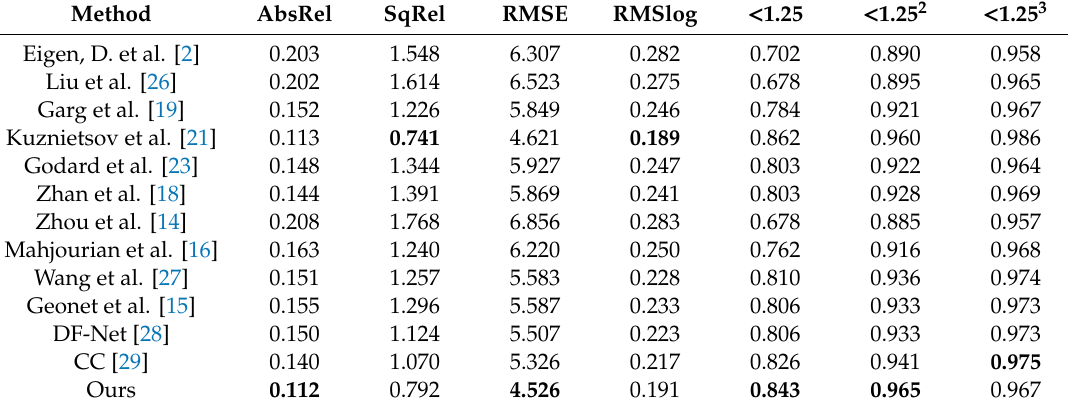
Table 1. Objective analysis (The black bold in the table indicates the best result).